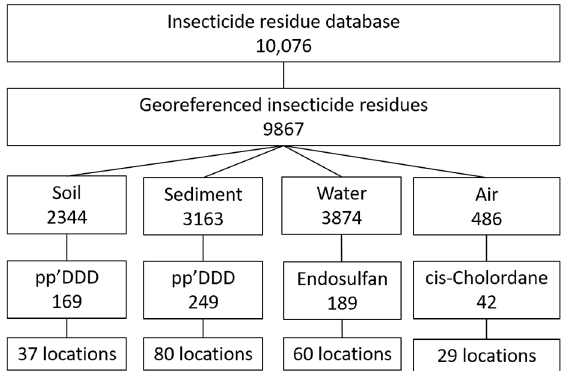
Figure 2. Extracting the number of locations and observations for the insecticide compound that was most frequently measured in soil, sediment, water and air. pp’DDD stands for pp’Dichlorodiphenyldichloroethane.